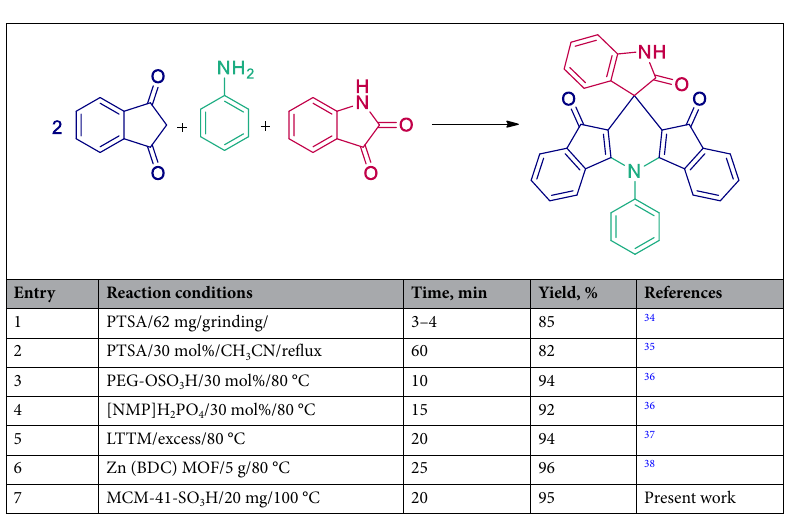
Table 3. The efficiency of MCM-41-SO 3 H as compared to other reported catalysts in the model reaction.